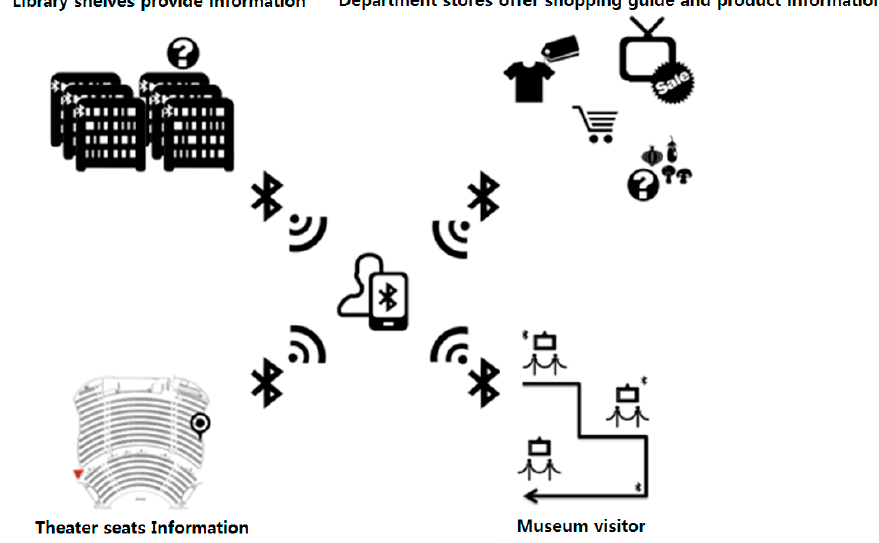
Figure 21. A Concept Diagram of the Indoor Positioning System Application. Figure 21. A concept diagram of the indoor positioning system